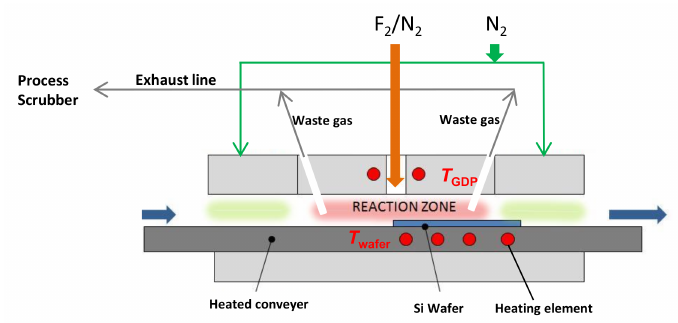
Figure 1. Schematics showing the atmospheric pressure dry etching (ADE) reactor and external connections to gas supply and exhaust